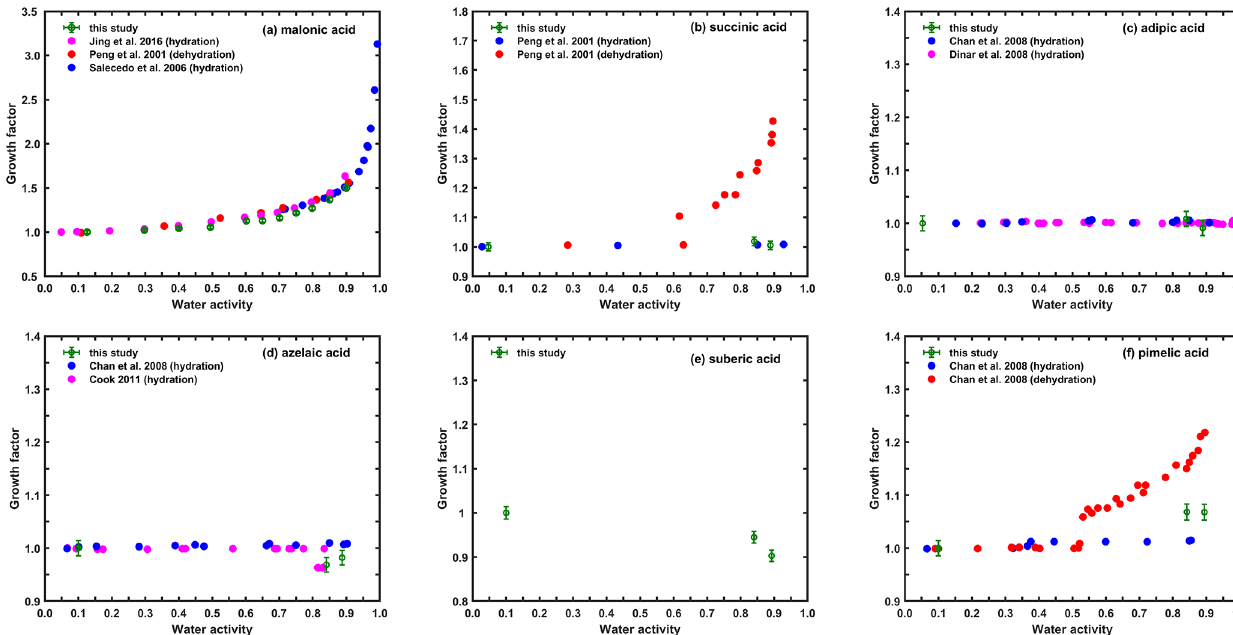
Figure 1. The hygroscopic growth values of straight-chain dicarboxylic acid particles (200nm) measured in this study and their individual comparison with previous studies.